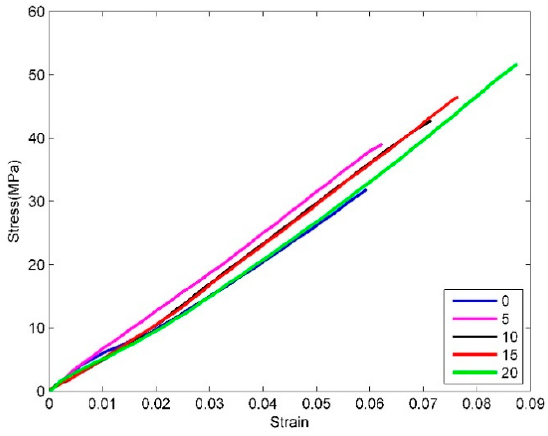
Figure 21. Tensile test stress-strain curve.